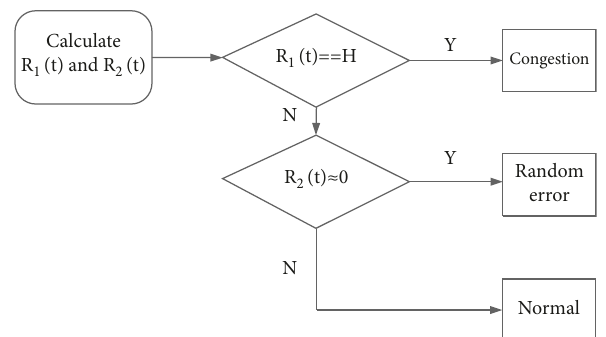
Figure 2: Routing parameter feedback network status.